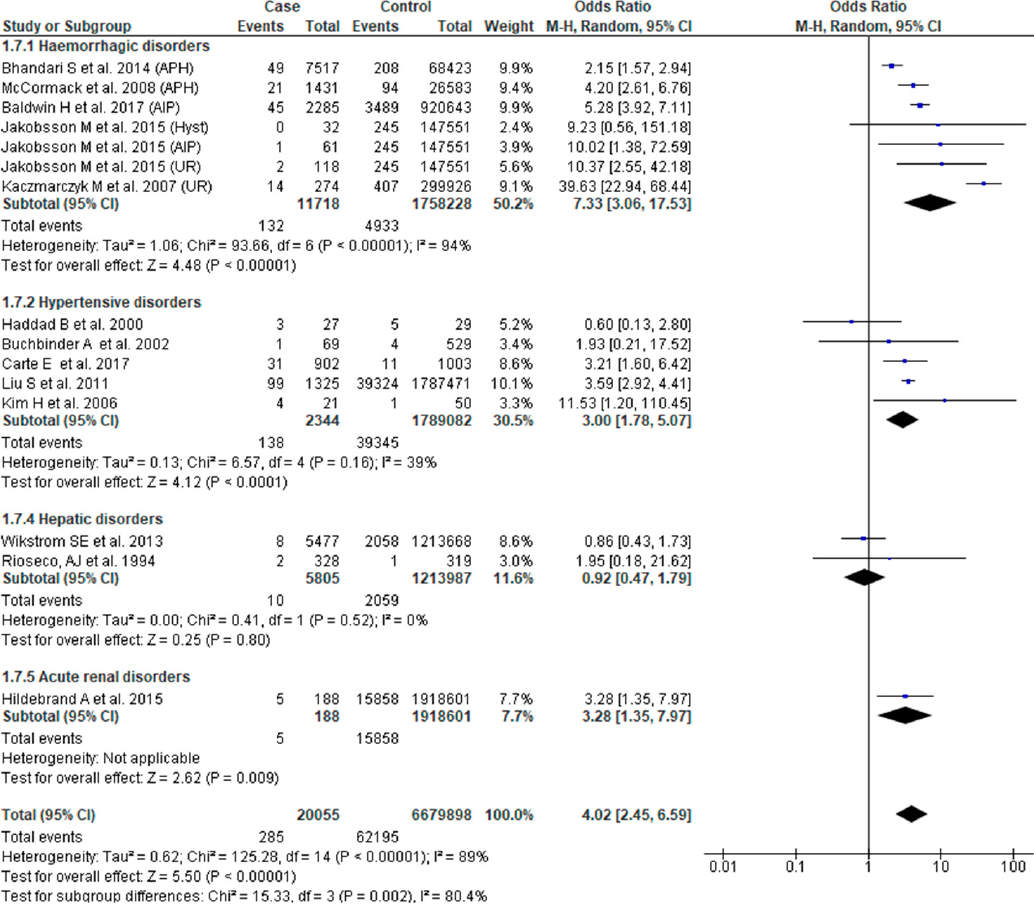
Figure 8. Forest plot of studies assessing association between Severe maternal morbidity (SMM) and neonatal death.